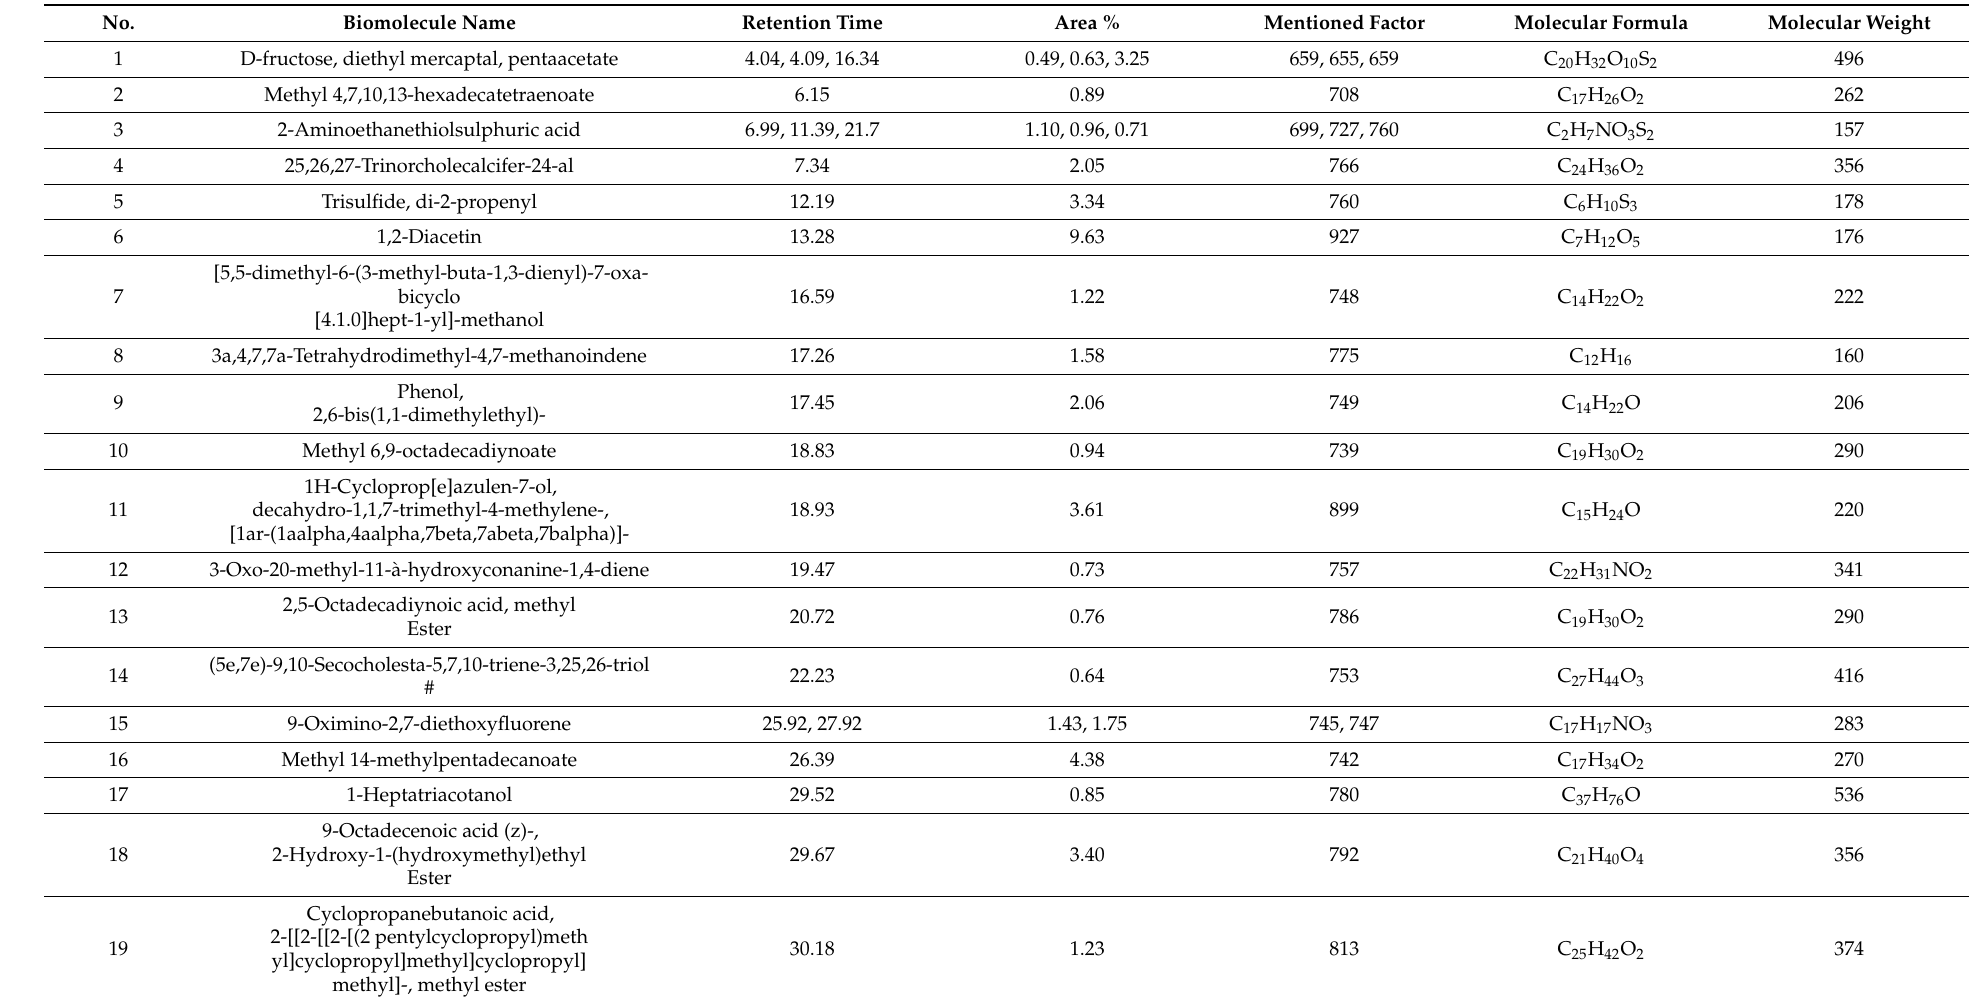
Table 1. Chemical composition analysis of the unicellular ulvophyte sp. MBIC10591 using